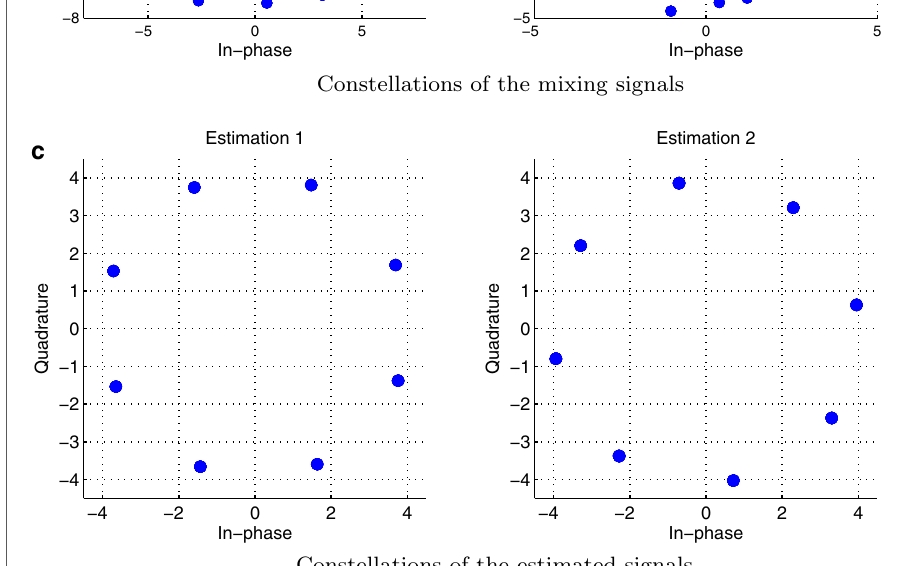
Fig. 1 Simulation result of the proposed algorithm for mixtures of two 8PSK signals, time delay τ =